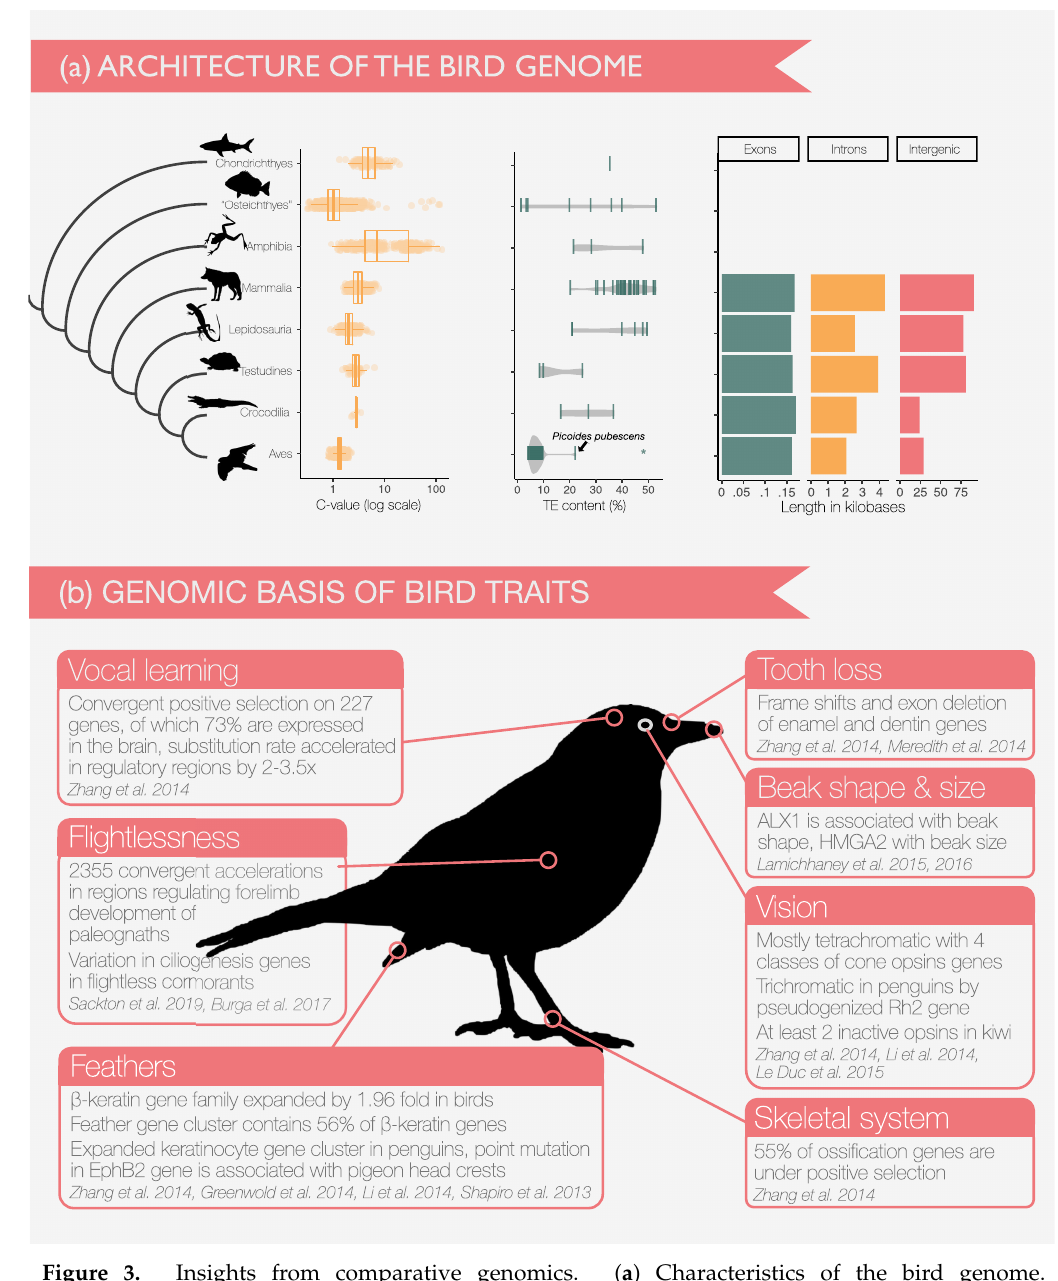
Figure 3. Insights from comparative genomics. ( a ) Characteristics of the bird genome. Left : The genomes of birds are small for vertebrates and smaller than all amniote genomes as shown in boxplots of C-values (the haploid nuclear DNA content picograms) for each clade and species-specific points. If multiple values for one species were available, we show the average. Data from http://www.genomesize.com/. Center : Birds have lower abundance of transposable elements (TEs) than other vertebrates. If multiple values for one species were available, we show the average. The asterisk marks the high TE density on a non-recombining region of the collared flycatcher, while the autosomes are within the range of other birds [108]. All other data were compiled from [9,107]. Right : Bird genes are shorter than those of other amniotes because of the reduction of intergenic and intron length. Data for amniotes from [9], unavailable for other vertebrates. ( b ) Selection of insights into phenotype-genotype interactions from bird